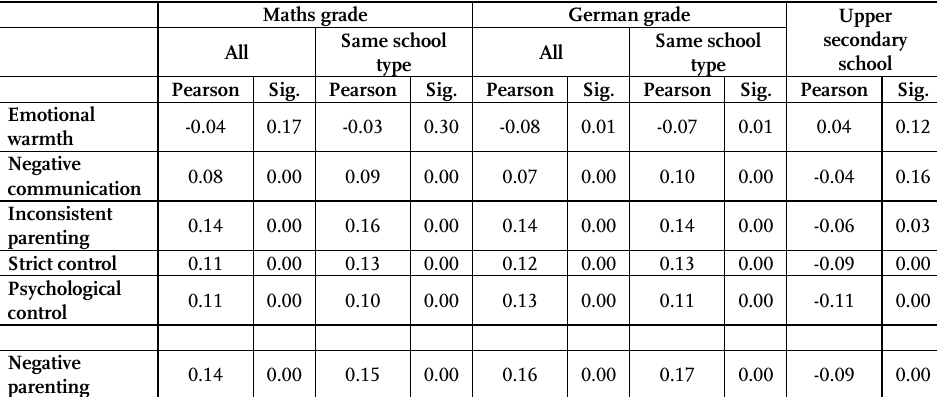
Table 7 : Correlation of parenting dimensions with school grades and track attendance (both twins included) Maths grade German grade Upper secondary Same school Same school All All school type type Pearson Sig. Pearson Sig. Pearson Sig. Pearson Sig. Pearson Sig. Emotional -0.04 0.17 -0.03 warmth Negative communication Inconsistent 0.14 0.00 0.16 parenting Strict control 0.11 Psychological control Negative parenting